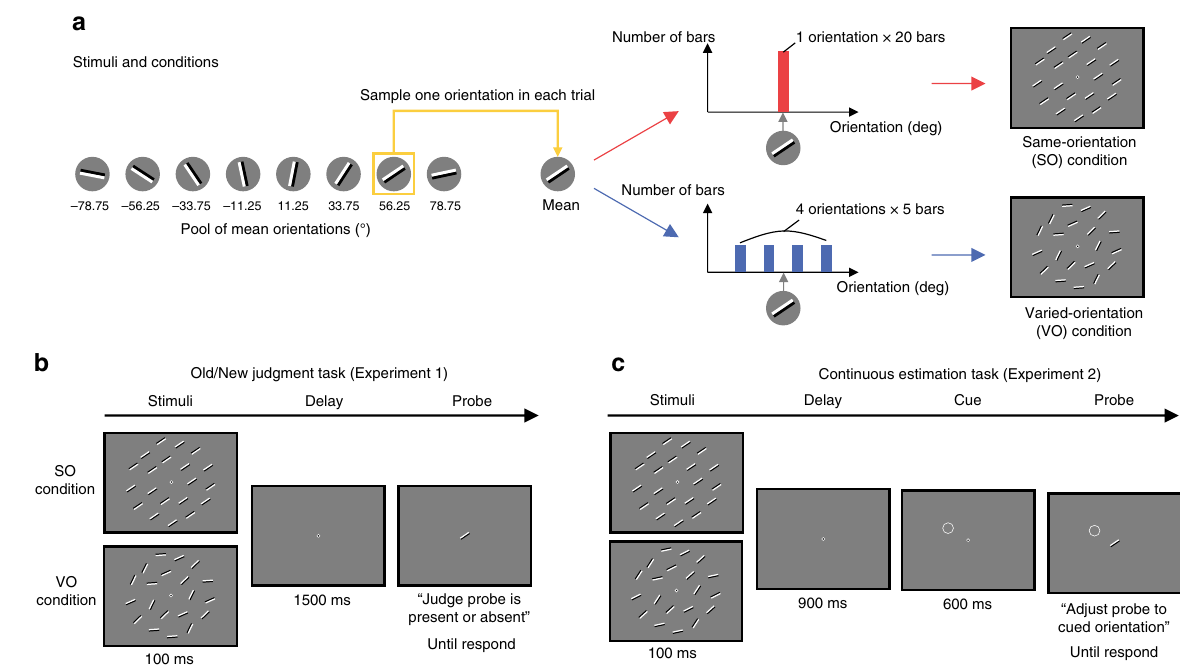
Fig. 1 Illustrations of stimuli, conditions, and task sequences. a Illustrations of how stimuli and conditions were created. First, one orientation was sampled from eight orientations and then used as a mean orientation in each trial of two conditions. In the same-orientation (SO) condition, the sampled orientation was identical to the orientation of 20 bars. In the varied-orientation (VO) condition, four orientations were varied around the sampled orientation, with 5 bars in each orientation, producing 20 orientations. b Trial sequence of the old/new judgment task in Experiment 1. Participants viewed the stimuli of the SO or VO condition for 100 ms. After a 1500 ms retention interval, the participants were asked to judge whether the probe was of a new orientation, or whether it was present in the old stimulus display. c Trial sequence of the continuous estimation task in Experiment 2. Participants viewed the stimuli of the SO or VO condition for 100 ms. After a 900 ms retention interval, the location cue indicated which stimulus the participants should estimate. Participants were then asked to adjust the probe orientation to the target orientation in the cued